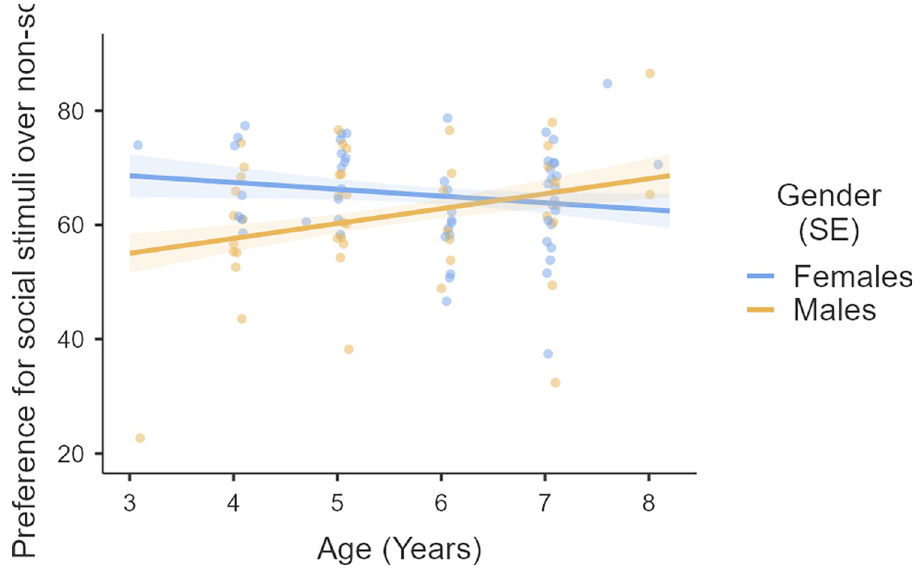
Fig 3. Line graph shows the interaction between age and gender when predicting preference for social stimuli on preferential looking task.